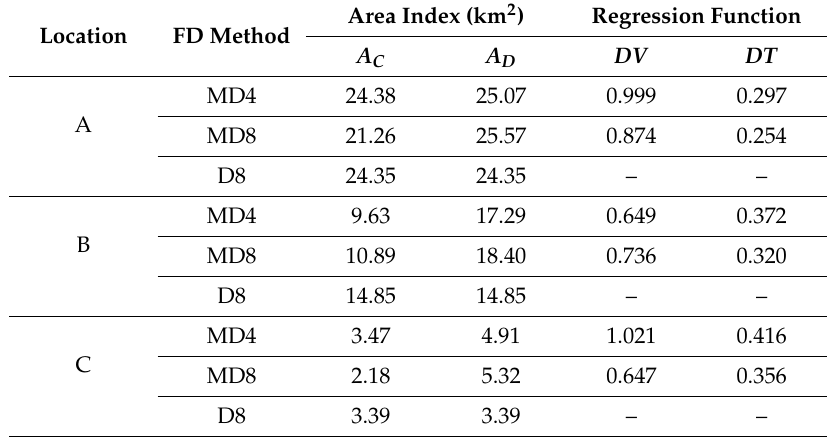
Table 3. Area indexes and estimated hydrography deviations ( DV and DT ) at the three locations in the Goodwin Creek